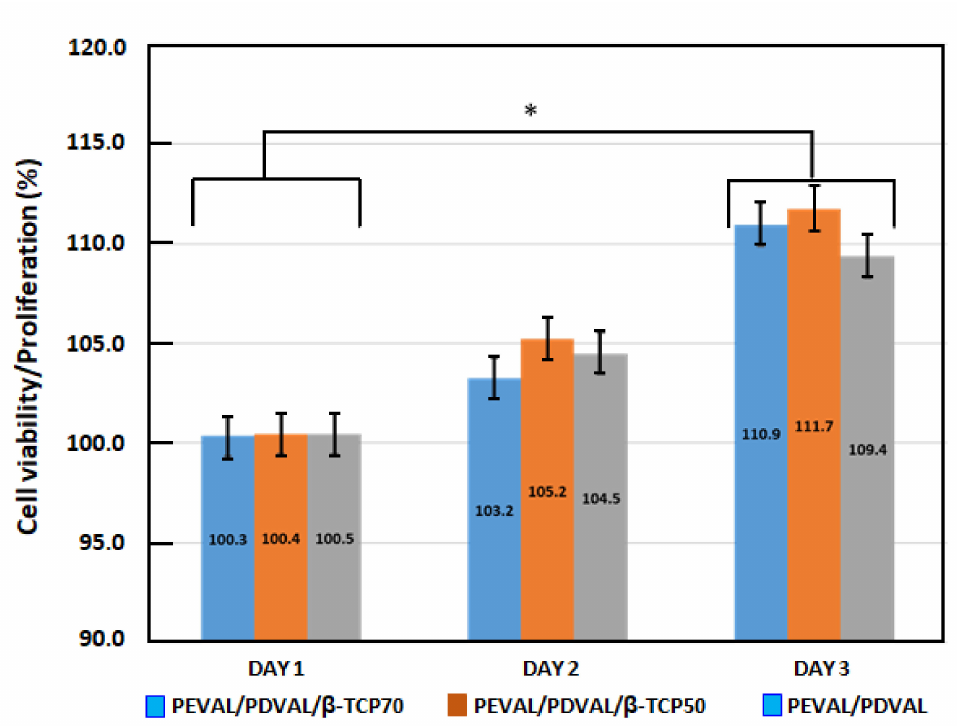
Figure 9. Cell viability and proliferation results on PEVAL/PDVAL/ β -TCP hybrid material scaffolds containing 50 and 70 wt% of β -TCP contents and the PEVAL/PDVAL blend (reference during 1, 2, and 3 days). * Statistically significant difference ( p -value <